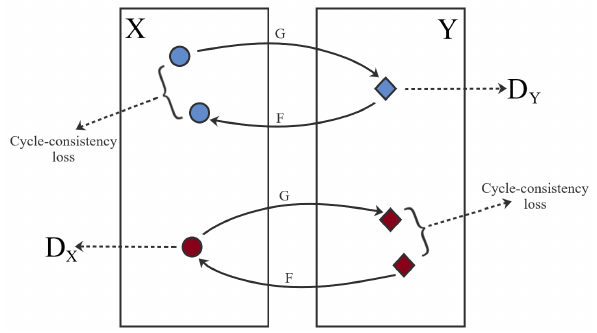
Figure 2. CycleGAN framework and training strategy. Blue—Forward cycle-consistency loss; Red — Backwards cycle-consistency